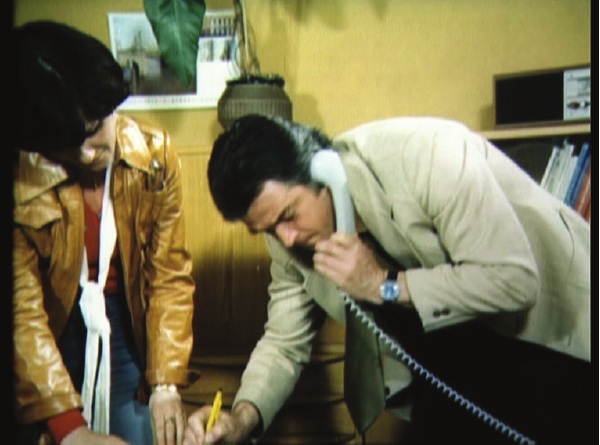
Figure 7. Overwork: ‘Die Herznerven’ [The Cardiac Nerves], Du und Deine Gesundheit , DFF, 1979